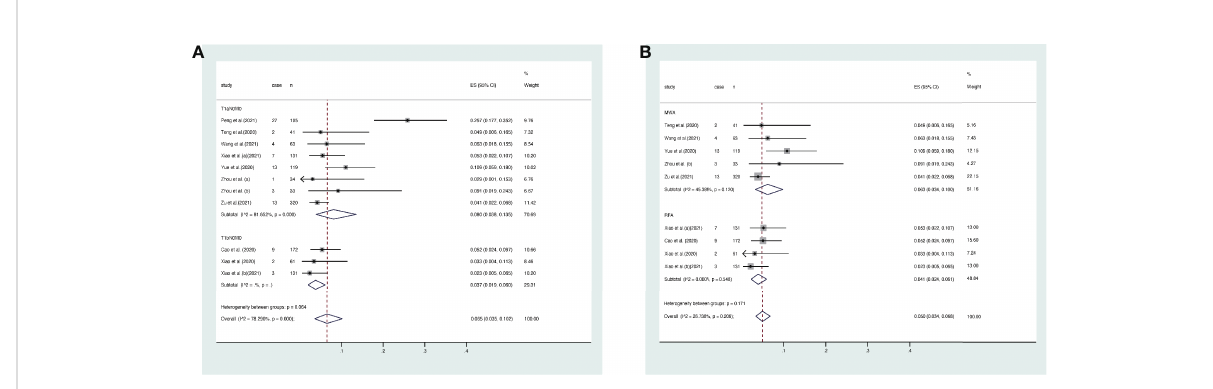
FIGURE 5 Egger ’ s funnel plot of the overall disease progress rate: (A) T1aN0M0 and T1bN0M0 studies, (B) MWA and RFA studies.